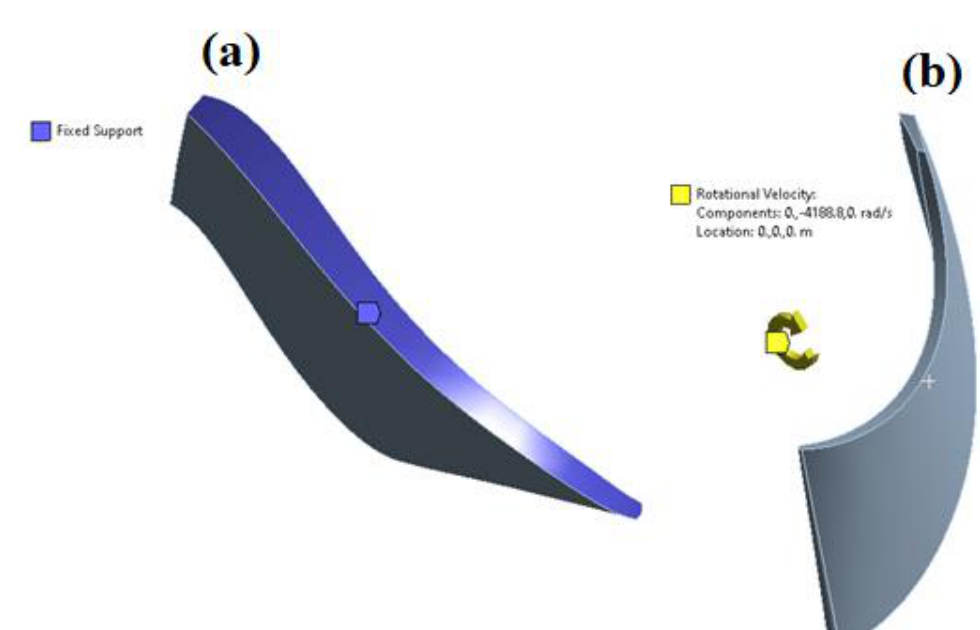
Figure 15. Specified boundary conditions for the finite element analysis (FEA), fixed support ( a ) and rotational speed and its axis ( b ).